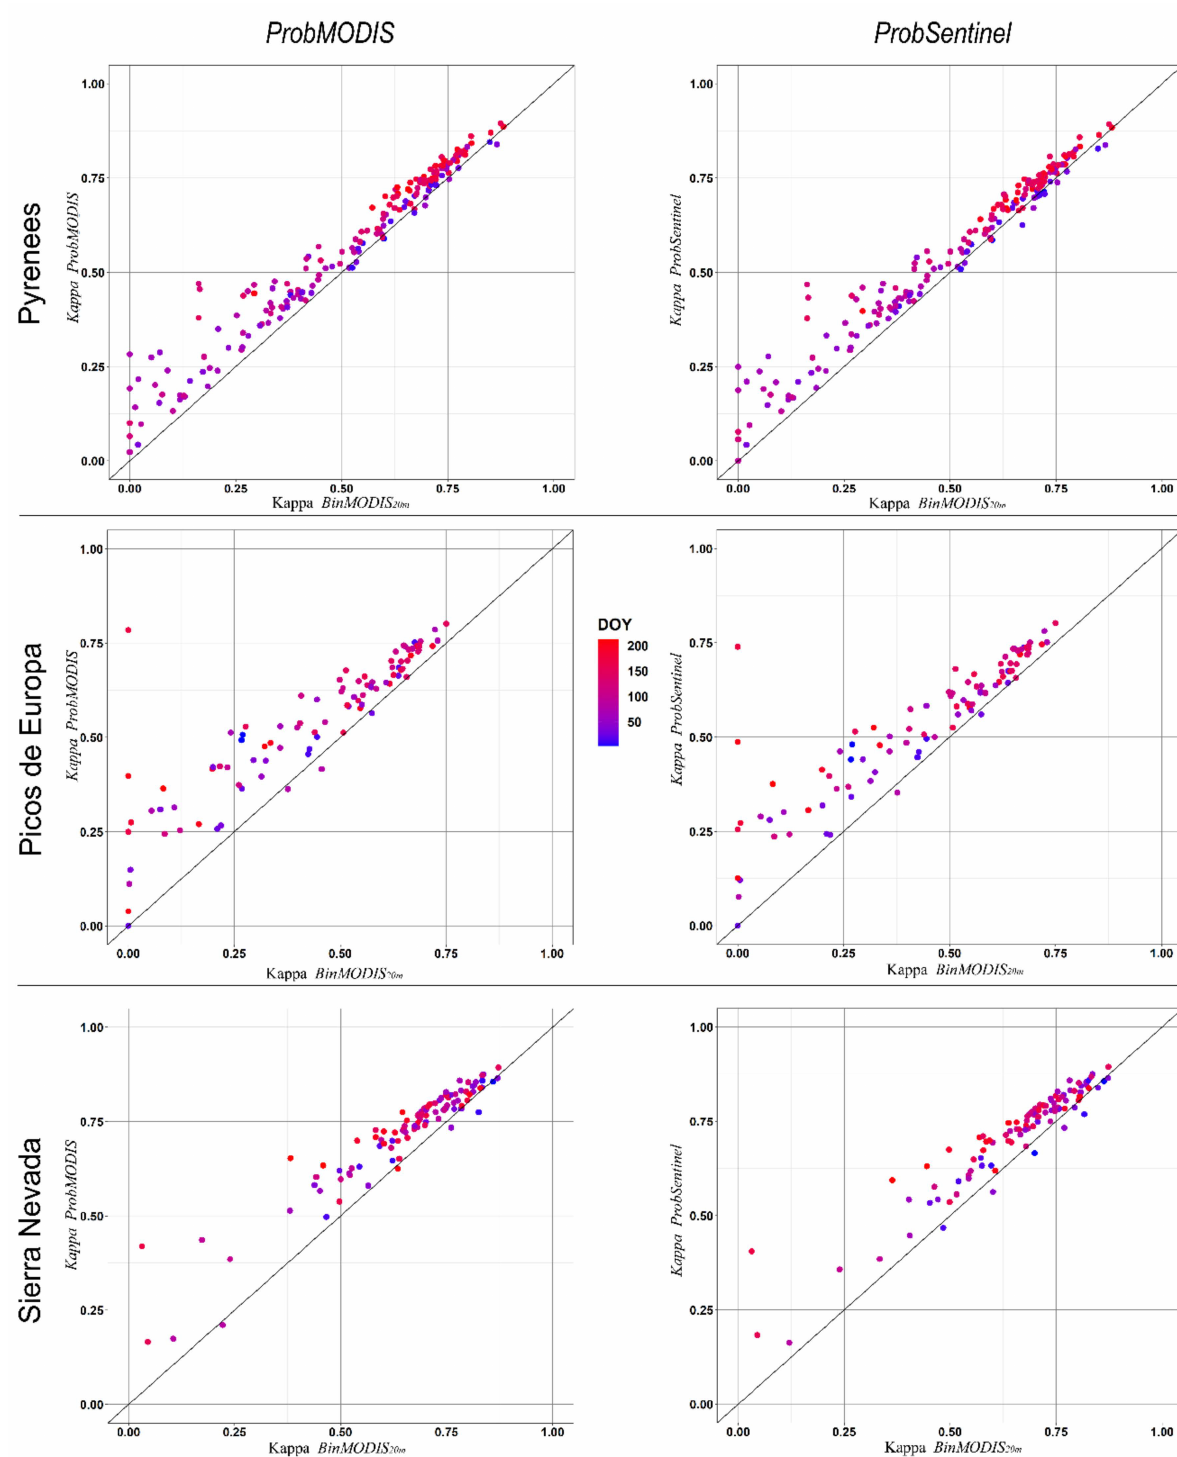
Figure 6. Kappa coefficient scatter plot of ProbMODIS (left panel graphs) and ProbSentinel (right panel graphs) versus the Kappa coefficients of BinMODIS 20m . The color scale depicts the day of the snow season (Day Of Year starting October